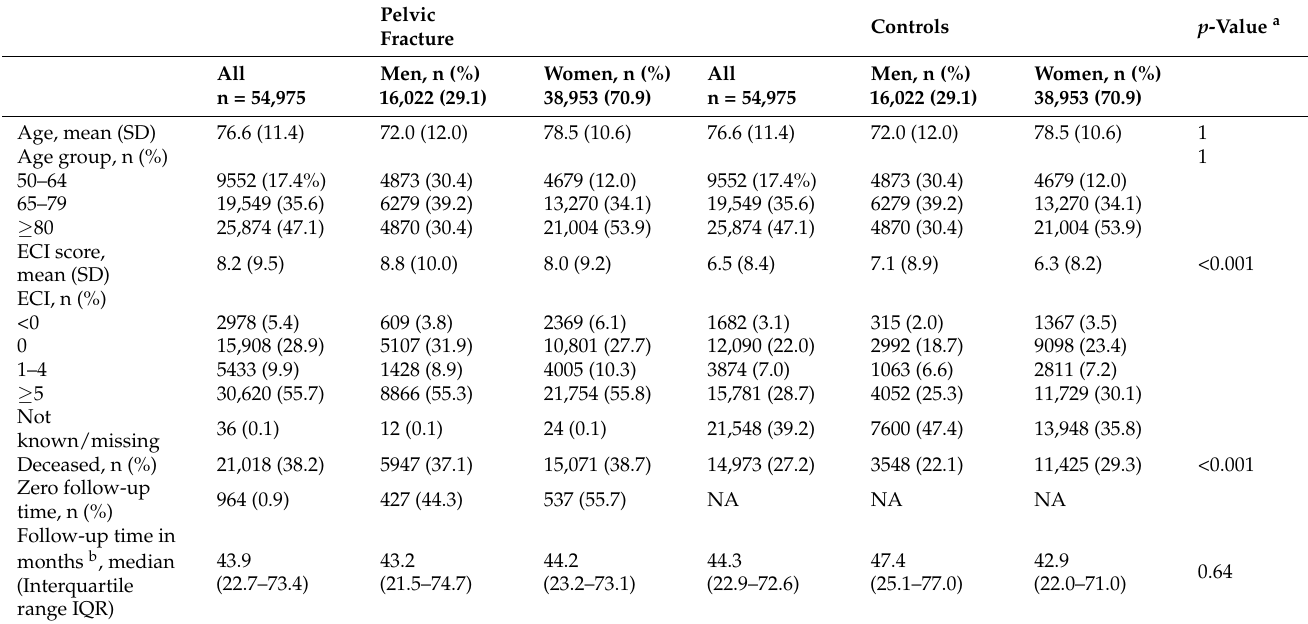
Table 1. Characteristics of patients with pelvic fracture and fracture-free controls.